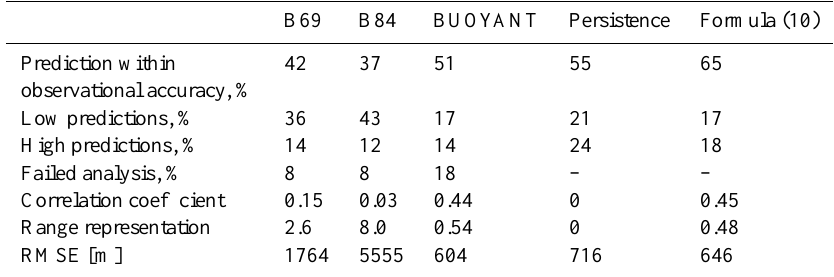
Table 1. Performance of B69, B84, BUOYANT and formula (10) approaches for the MISR dataset.